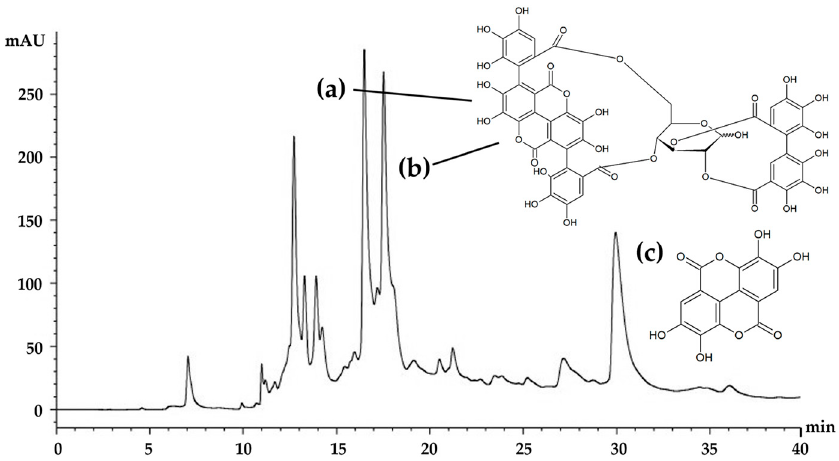
Figure 6. HPLC chromatogram of the E60 extract, which was Sripanya pomegranate peel extract obtained by maceration in 60% v / v of ethanol. (a) and (b) are punicalagin derivatives, whereas (c) is ellagic acid.